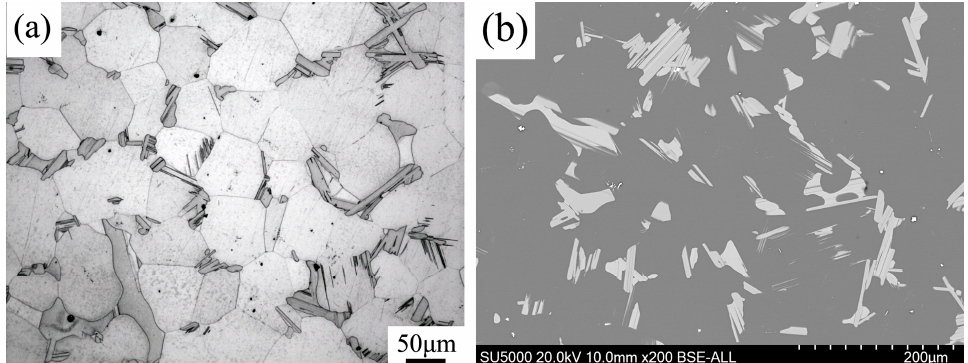
Figure 5. The microstructure of the Mg-12.0Gd-4.5Y-2Zn-0.4Zr alloy after homogenization: ( a ) OM; and ( b ) BSE-SEM micrographs.